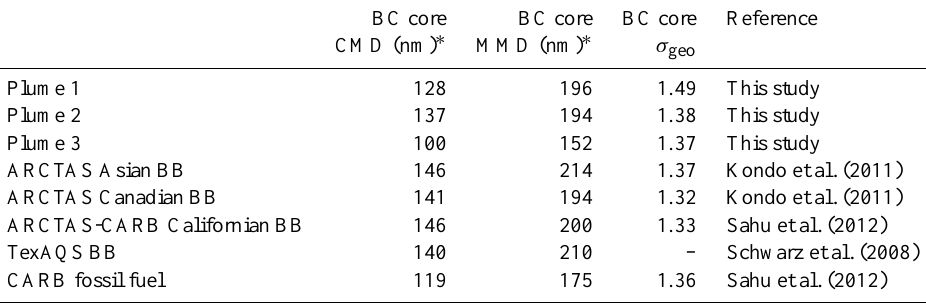
Table 2. BC core size distribution properties for the three plumes, and a comparison of literature values. σ geo refers to the geometric standard deviation. The ARCTAS values are averages of multiple fires sampled over North America.